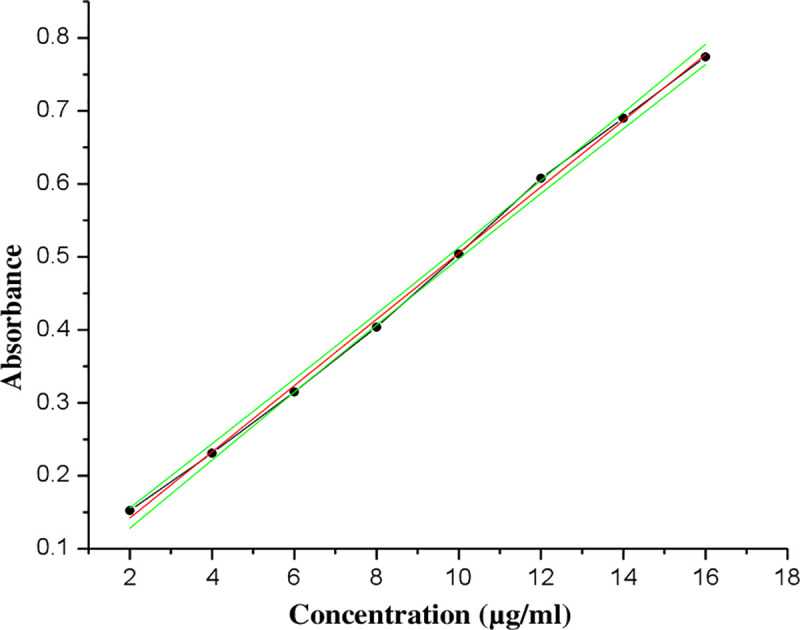
The UV absorption calibration curve of diclofenac sodium in PBS (pH 7.4) at 276 nm with 95% confidence bands for mean, (r2 = 0.9987).